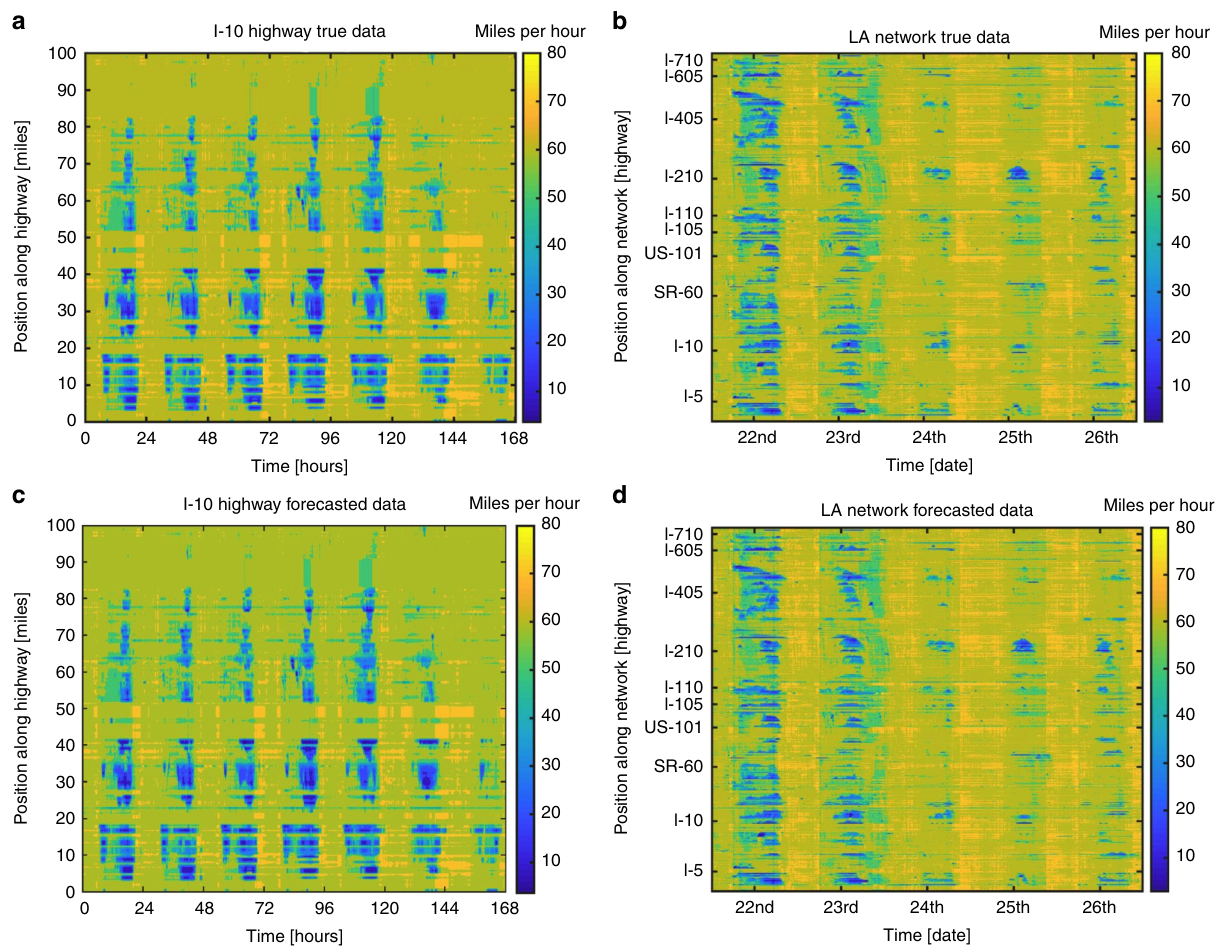
Fig. 6 Comparison of the true and forecasted data for the I-5 and LA network. a , b Raw data collected from PeMs for the I-10E and southern California network. The data was collected for a week and 5 days respectively. The I-10 highway seems to be mostly congested throughout the week until Sunday. As expected, all highways within the network seem to be congested on the days leading up to Christmas eve (12/21 – 12/22). Interestingly, there appears to be drastic relief in congestion during and after the actual holiday dates of 12/24 – 12/26. c , d Forecasted data generated by the MH-HDMD utilizing the last 15 min of data to forecast the next 15 min. The network was forecasted by concatenating data obtained for individual highways and applying the MH- HDMD algorithm to the concatenated data. By visual inspection alone the raw and forecasted data sets are indistinguishable, indicating an accurate forecast. Nevertheless, there is some error present within our forecasts which can be referenced in Fig. 7. The source data underlying Fig. 7a, b are provided in the Source Data fi